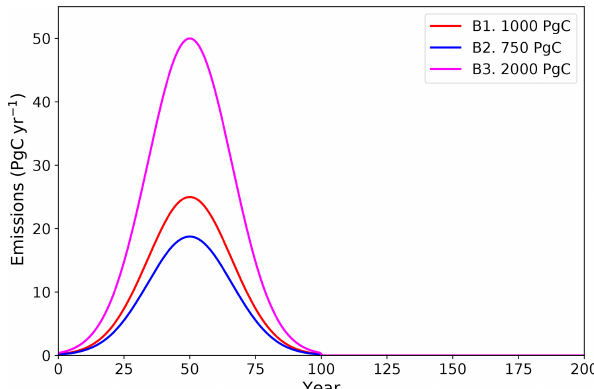
Figure 2. Time series of global CO 2 emissions for bell-shaped curve pathways B1 to B3. The numbers in the legend indicate the cumulative amount of CO 2 emissions for each